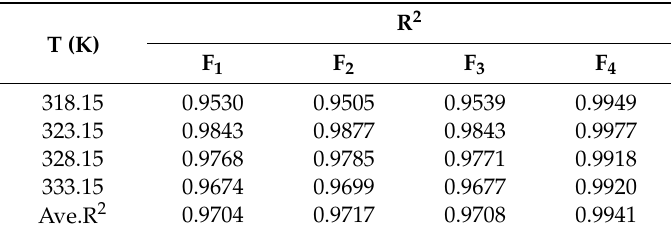
Table 4. The coe ffi cients of determination R 2 for di ff erent growth mechanisms of Li 2 CO 3 under di ff erent temperatures.